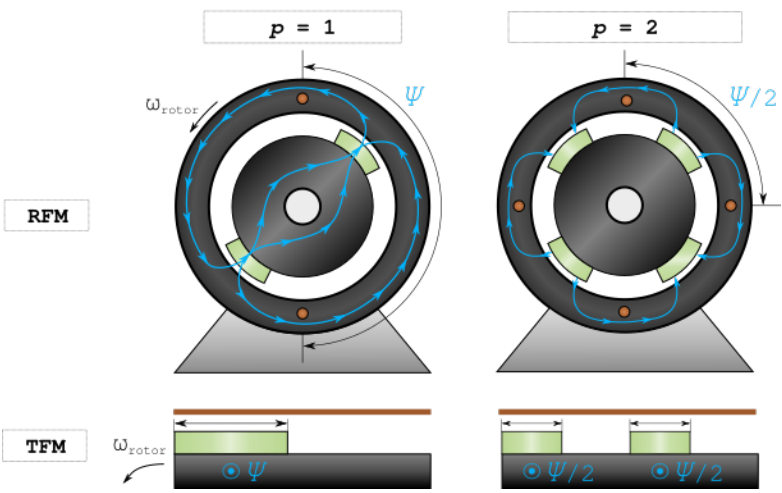
Figure 3. Increase of the pole pairs in RFMs and